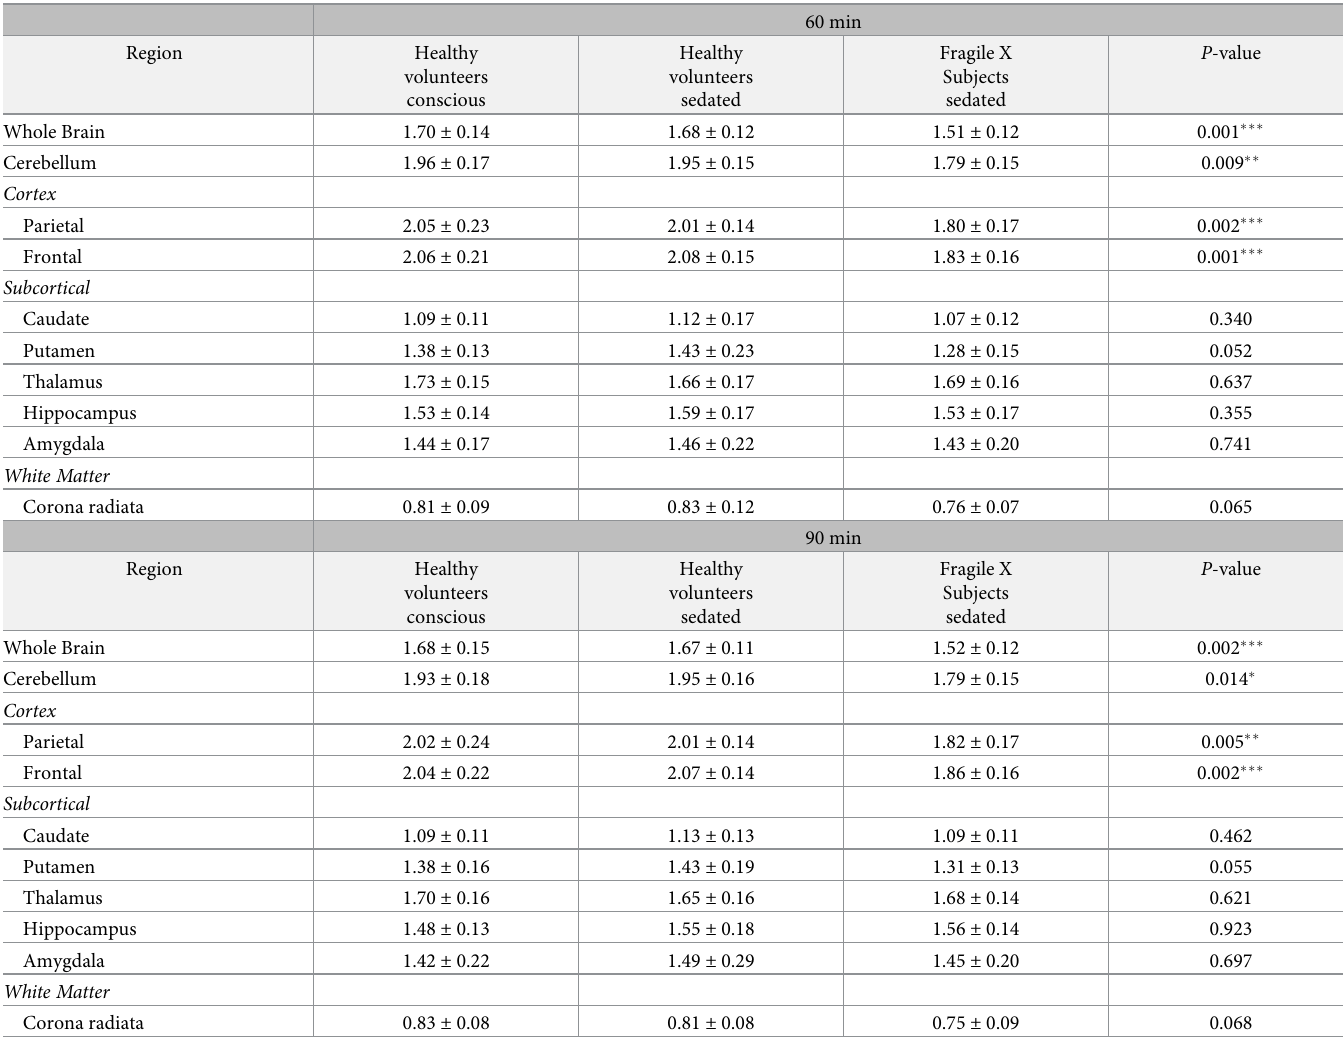
Table 1. Regional rates of cerebral protein synthesis (nmol/g/min). Region Healthy